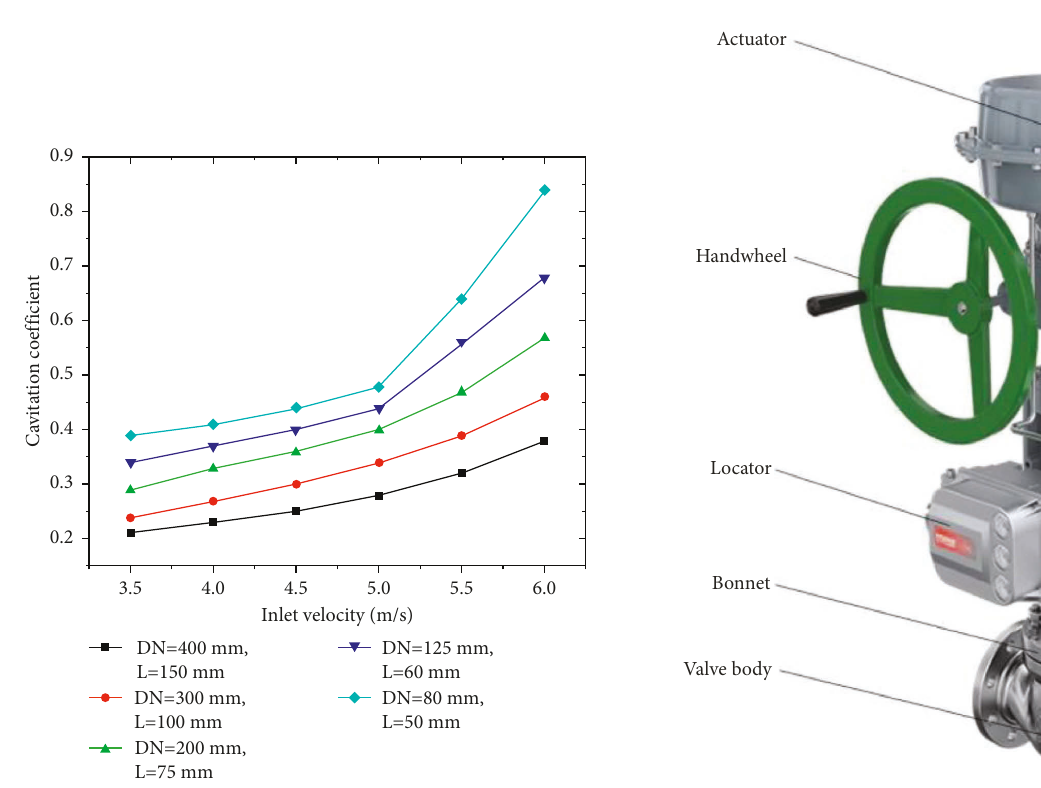
Figure 45: Variation of inlet velocity and cavitation coefficient with nominal diameter at half opening.